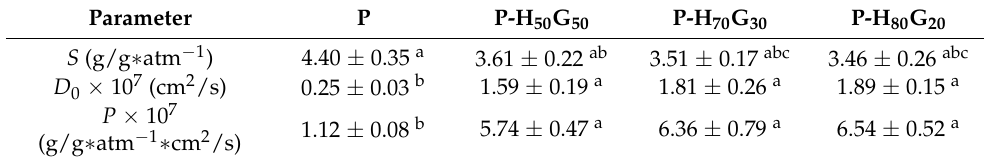
Table 5. Sorption, diffusion, and permeability values of pectin and pectin composites. Parameter P